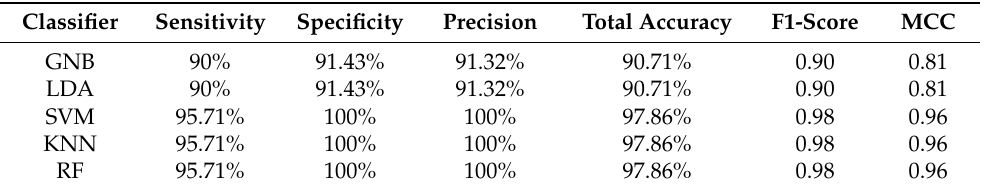
Table 4. Classification performance of different classifiers discriminating 14 SCZ from 14 HC subjects from dataset available at RepOD [58] using 5-fold